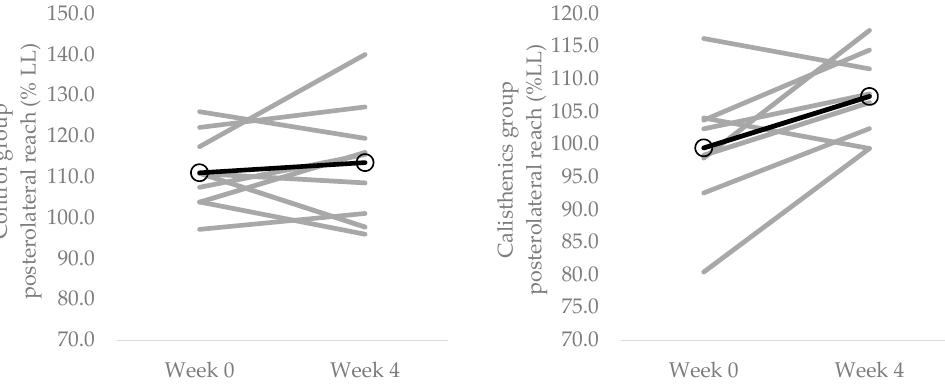
Figure 3. Individual changes (grey lines) in Y balance test posterolateral reach with left leg stance from baseline (week 0) to the end of the intervention (week 4). Left panel = control group; Right panel = calisthenics intervention group CV. Dark lines represent group means.